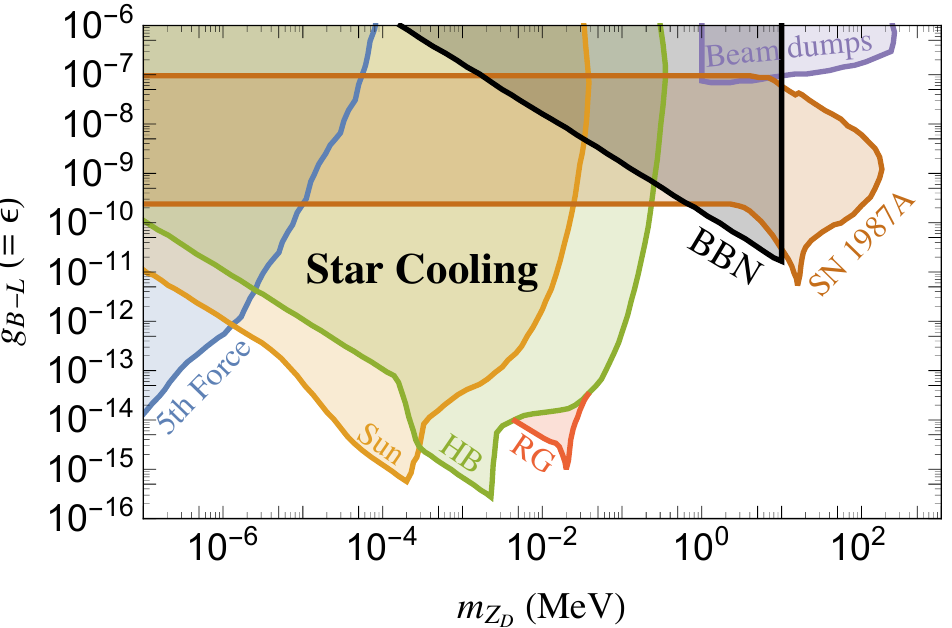
Figure 9. Constraints on light, weakly coupled B (cid:0) L dark vectors. There are limits from (left to right) (cid:12)fth force experiments [19, 87{90], stellar cooling through emission of dark vectors in the sun (Sun), horizontal branch stars (HB), and red giants (RG) [19, 92], BBN [91, 92], the cooling of supernova 1987A [92, 93], and beam dump experiments